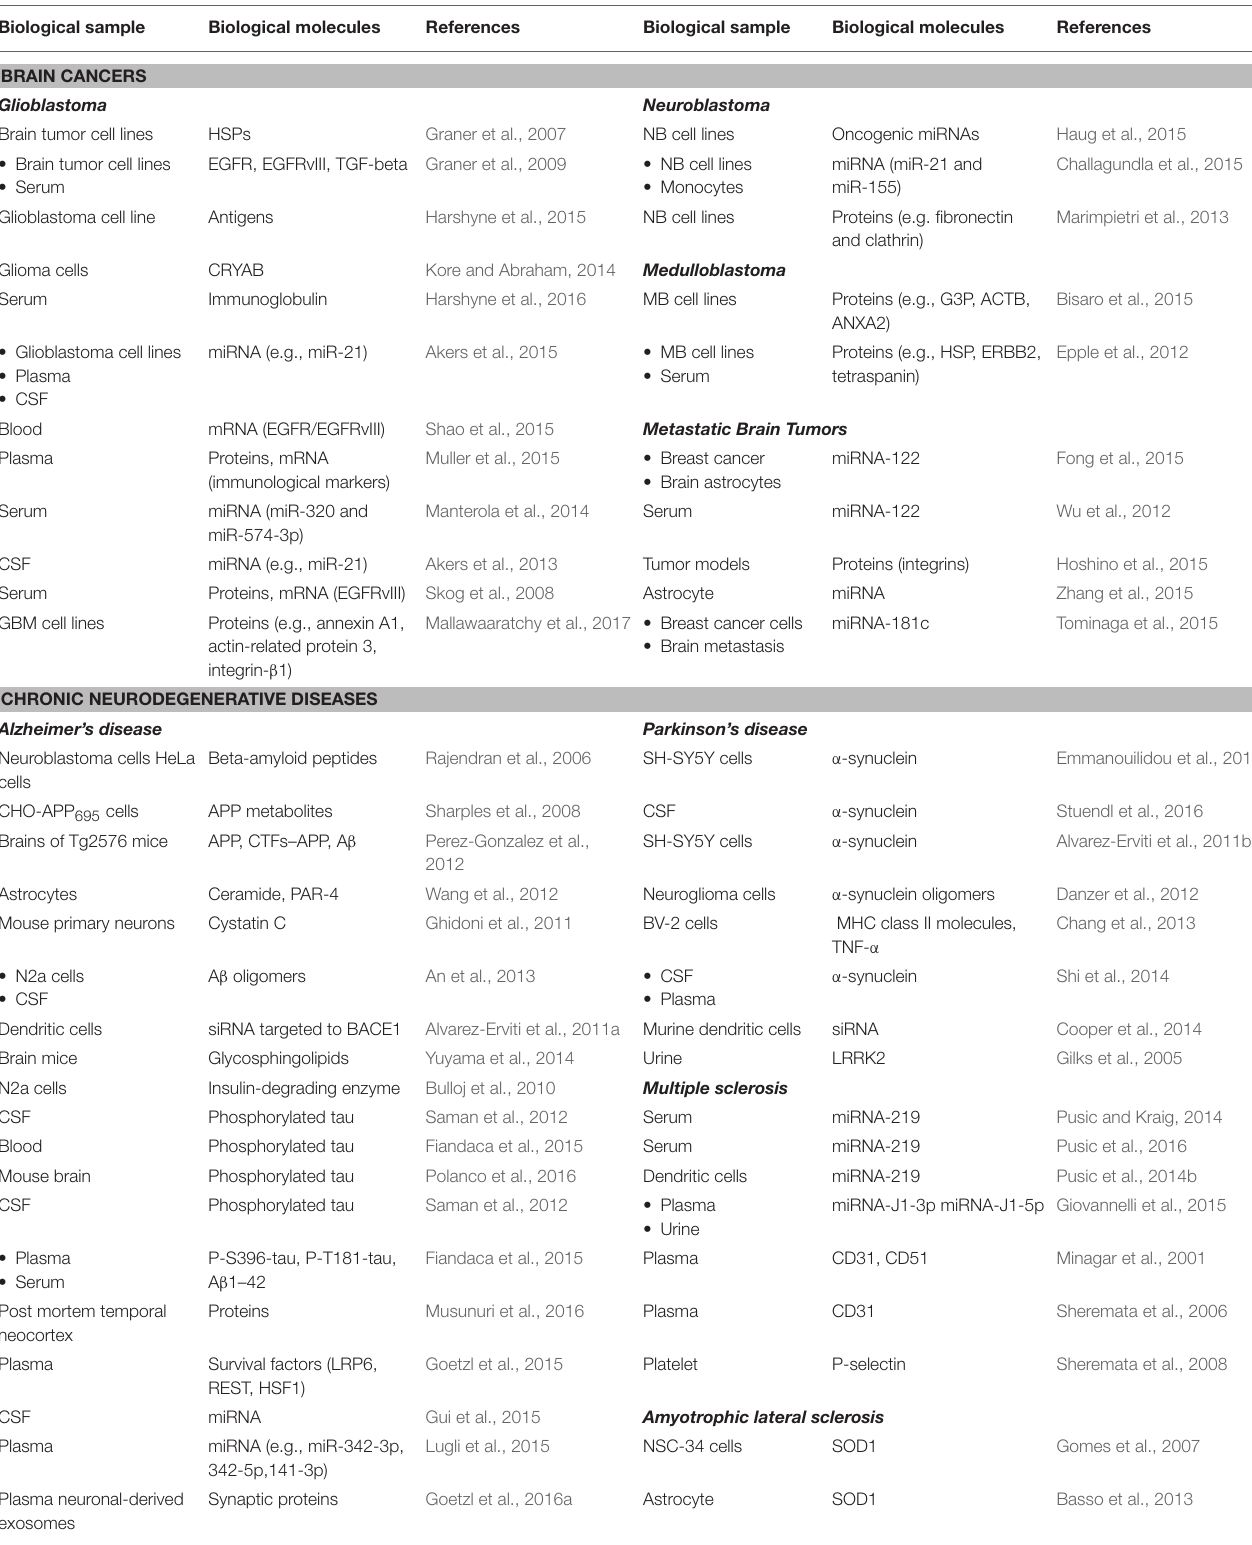
TABLE 1 | Molecules present in vesicles in different biological